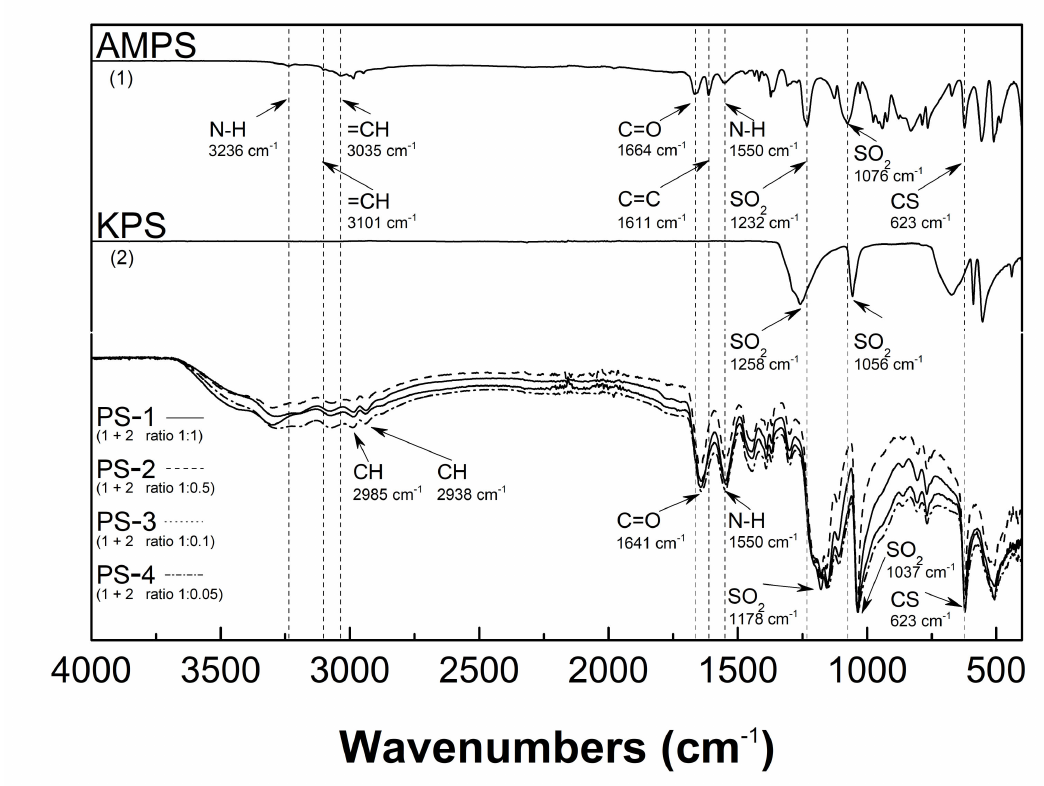
Figure 5. Attenuated total reflection-Fourier transform infrared (ATR-FTIR) spectroscopy: spectra of the monomer—2- acrylamido-2-methyl-1-propanesulfonic acid (AMPSA), the initiator—potassium persulfate (KPS), and synthesized PS1–PS4